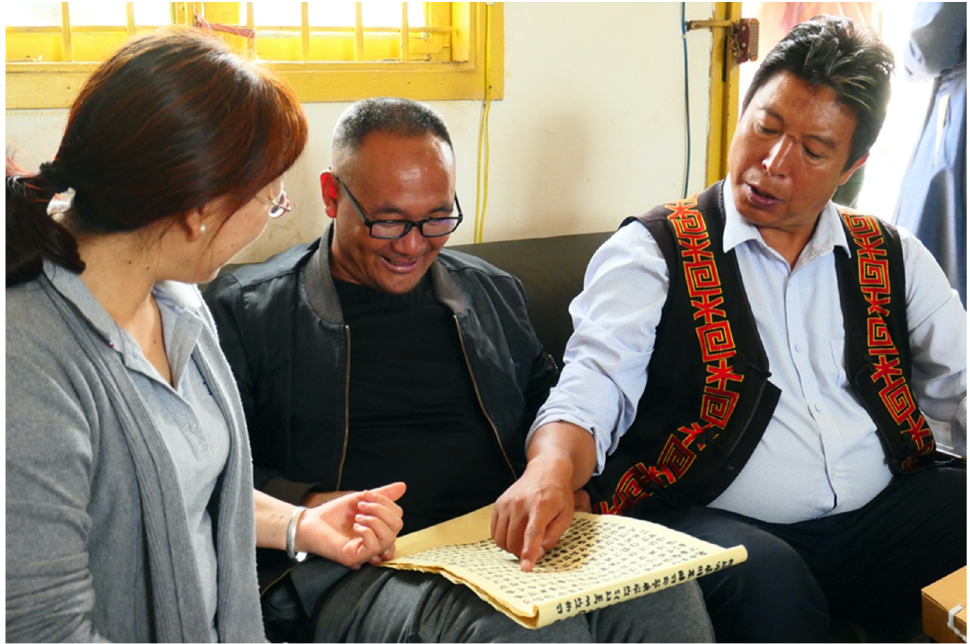
Figure 3. Scholars discussing Nuosu scriptures at an ethnological institution in Liangshan, 2019. Photograph by the author.